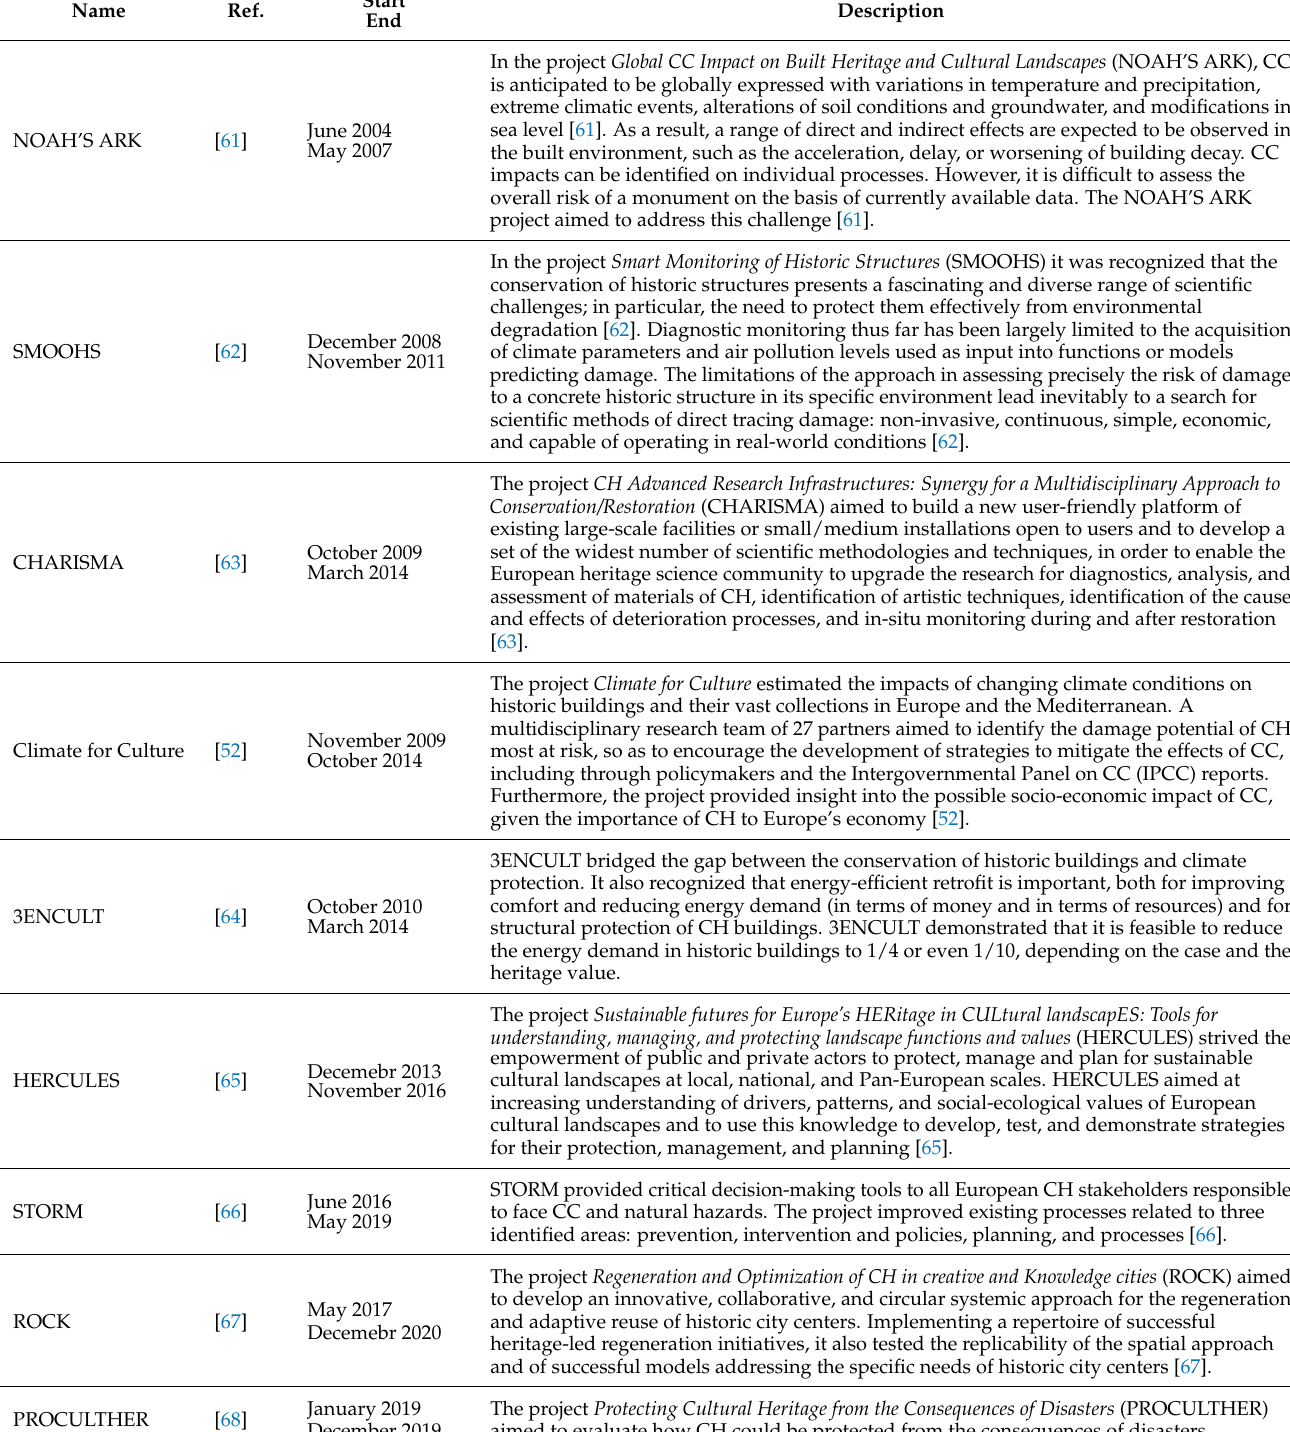
Table 5. Previous projects within the topic of CH, Hygrothermal conditions, and